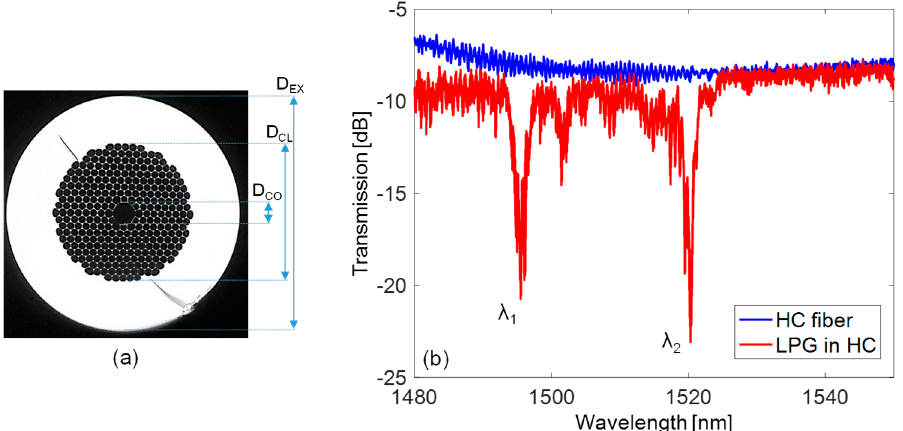
Figure 6. ( a ) Transverse section of HC-1550-02 Hollow core Photonic crystal fiber; ( b ) Comparison between transmission spectra of pristine HC fiber spliced with SMFs and with arc-induced LPG.